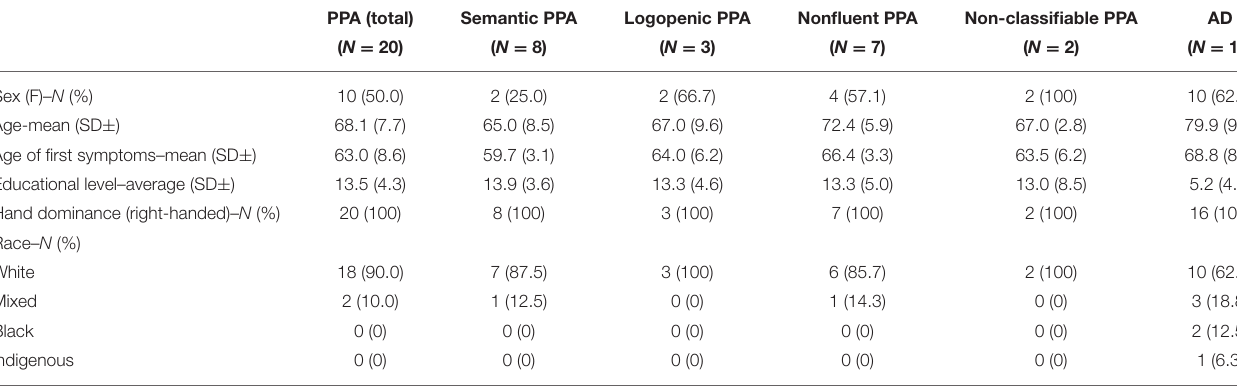
TABLE 1 | Sociodemographic characteristics of the participants.